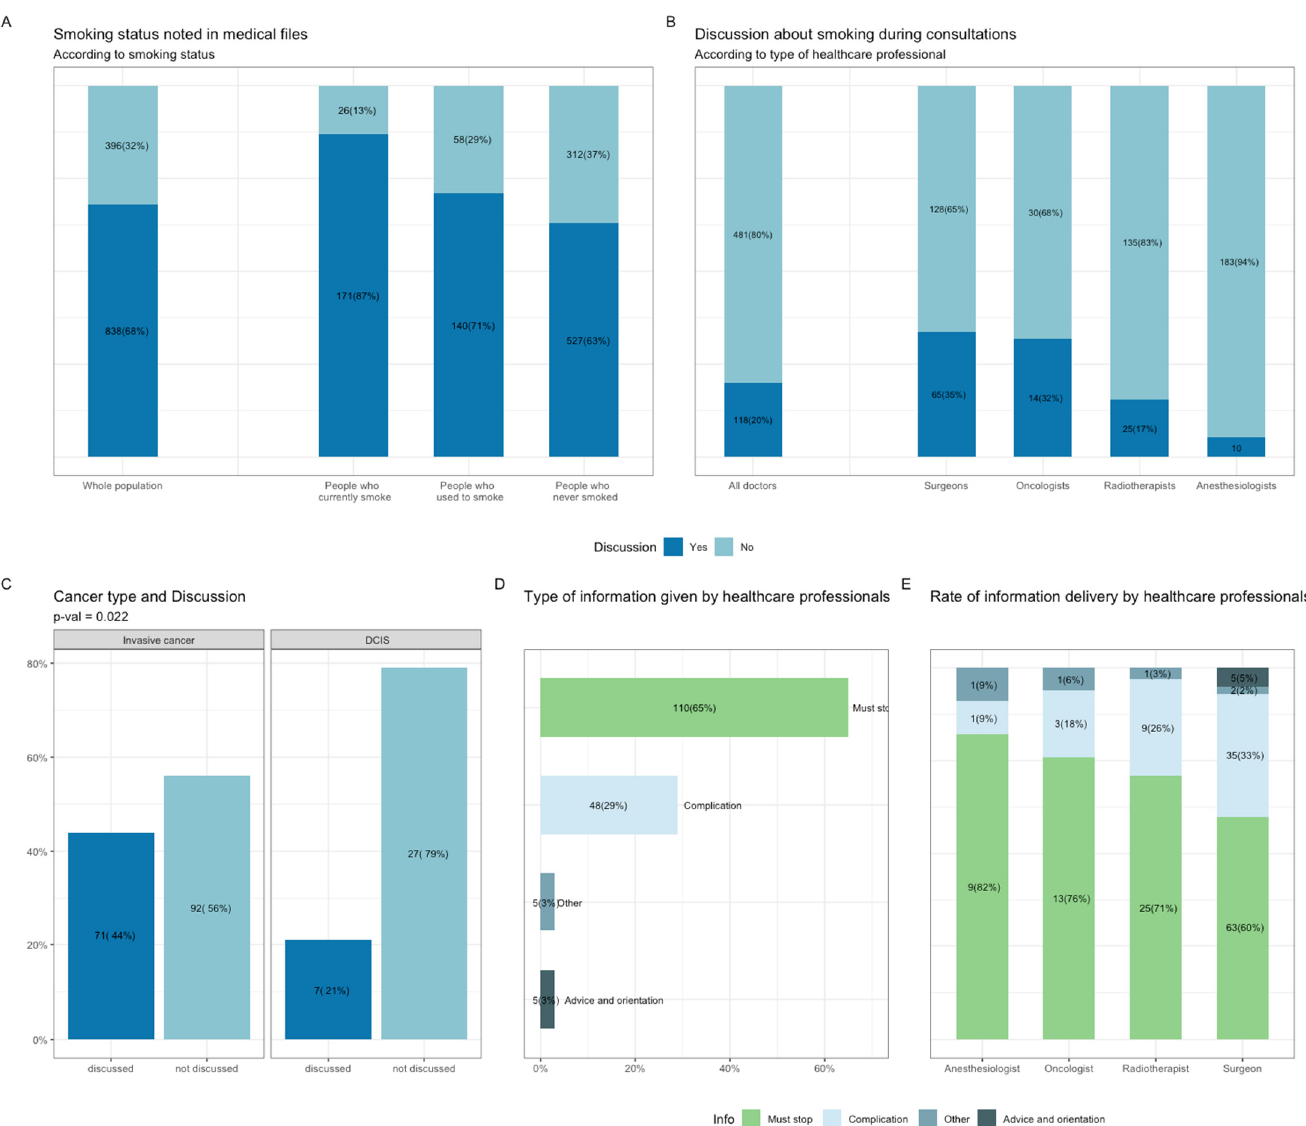
Figure 2. Smoking assessment and counseling by health care professionals at the time of BC diagnosis. ( A ), Smoking assessment reported in electronic health records (EHR) among the whole population and according to smoking status at diagnosis. ( B ), Smoking discussion during consultations with health care practitioners and according to each specialist (Surgeons, Oncologists, Radiotherapists, Anesthesiologists). ( C ), Discussion on tobacco consumption according to cancer type. ( D ), Information type provided by health care professionals. Subcategories were: general advice on smoking cessation (Must stop); treatment complications (Complication); practical advice and orientation (Advice and orientation) and Other. ( E ), Information type according to each specialist. Abbreviation: BC, breast cancer; EHR, electronic health records; BMI, body mass index.